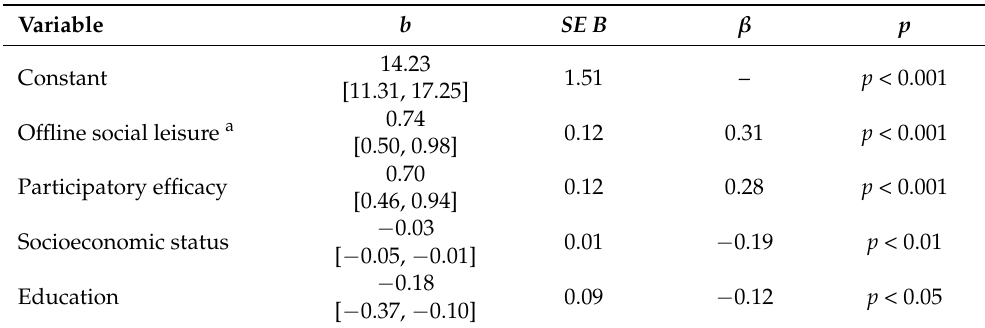
Table A2. Results of the Mediation Regression Analysis, Denoting the Relationship of All Predictors on Political